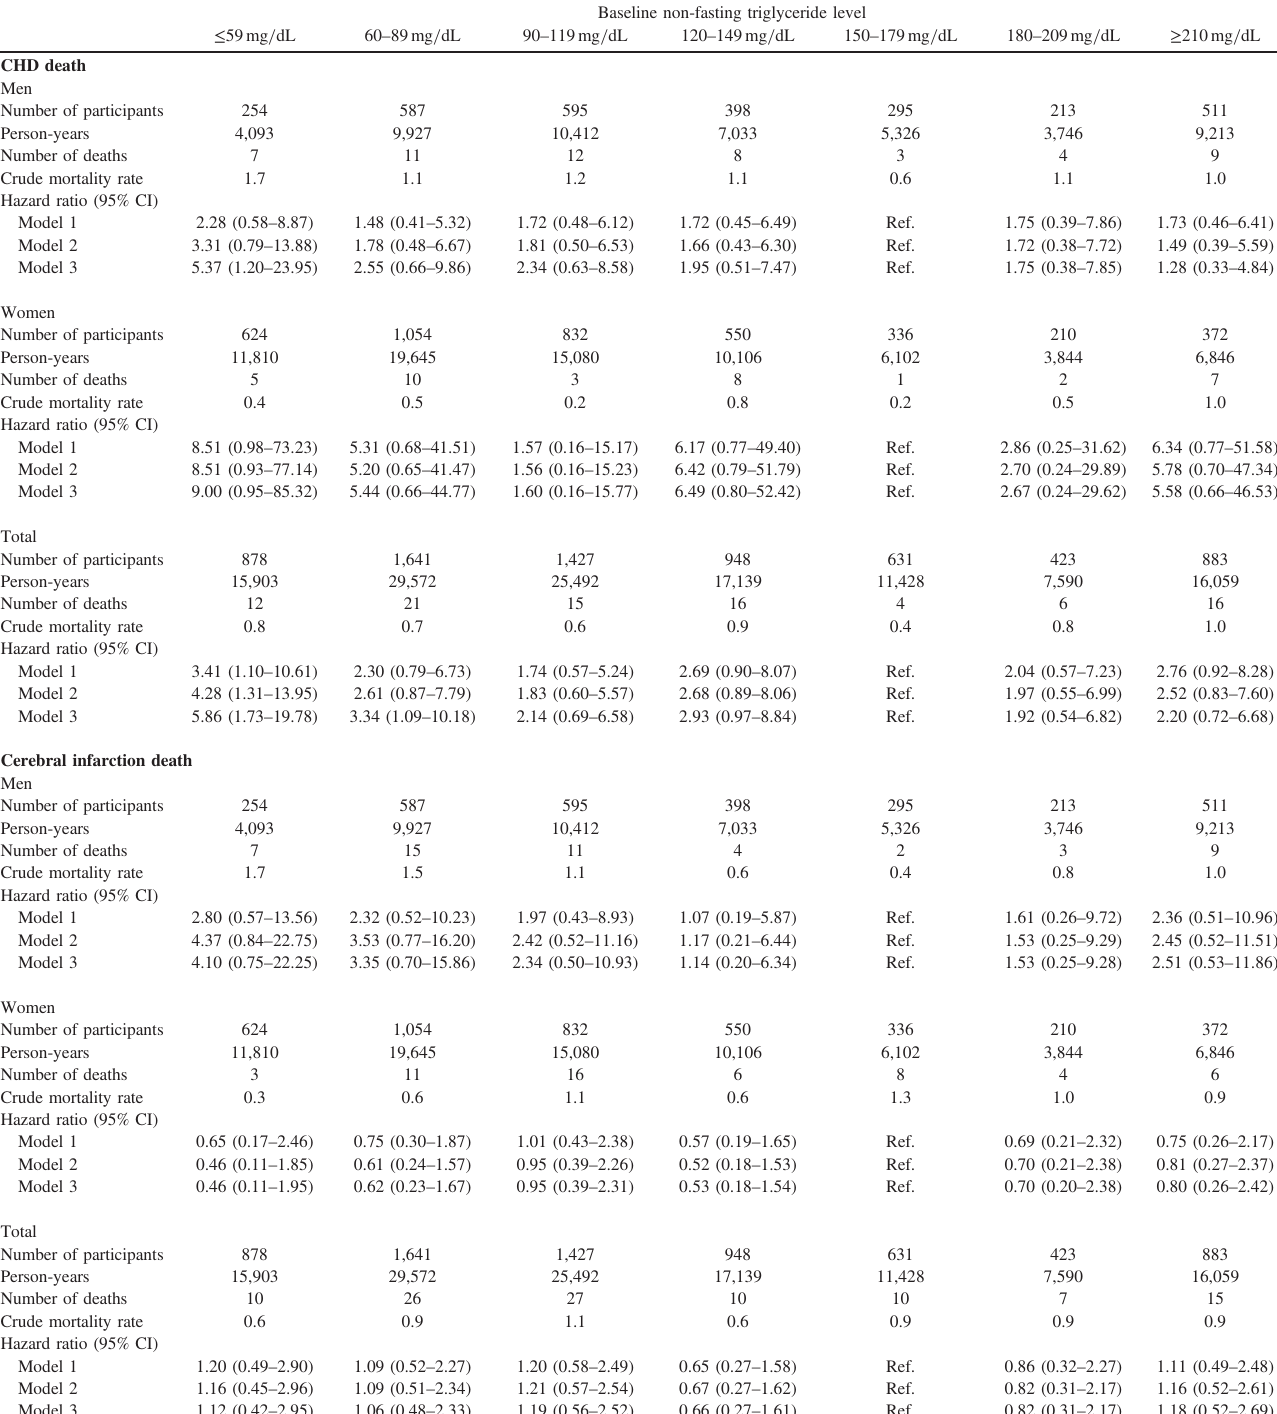
Table 4. Crude mortality rates and hazard ratios for CHD mortality and cerebral infarction mortality according to non-fasting triglyceride